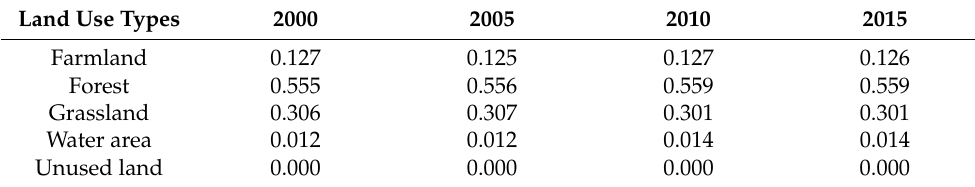
Table 8. Coefficient of sensitivity derived from equivalence coefficient adjustment.